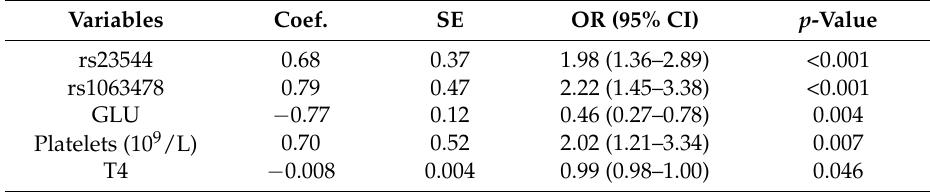
Table 4. Multivariate Stepwise regression analysis for independent factors of SVR.